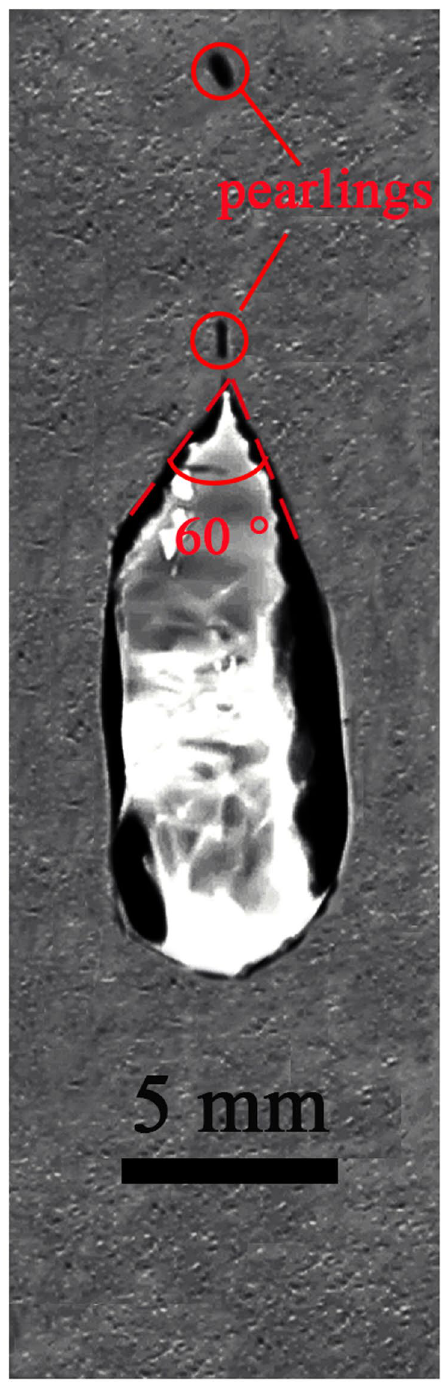
Figure 7. Pearling drop releasing from droplets at the angle Φ = 30°, which is the half angle of the indicating here γ is the liquid–vapor interfacial tension, w is the width of the liquid-solid contact area, θ a and θ r are the advancing and receding angles respectively. In the absence of Lamb waves, when the glass plate is inclined in the inclination angle of remains at equilibrium on the inclined glass plate owing to the gravitational force attempting to deform the drop- let and the force formed by contact angle hysteresis (CAH) is intended to prevent such drop motion. It is found that a drop in its critical configuration satisfies the relation 19